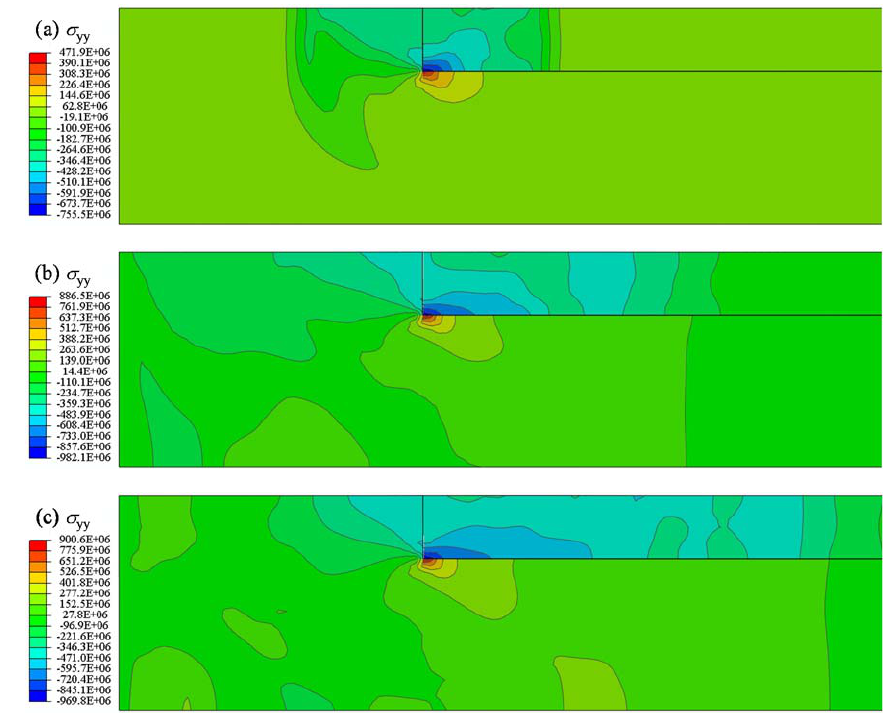
Figure 3. Contours of the axial stress component ( σ yy ) around the flange structure region for the